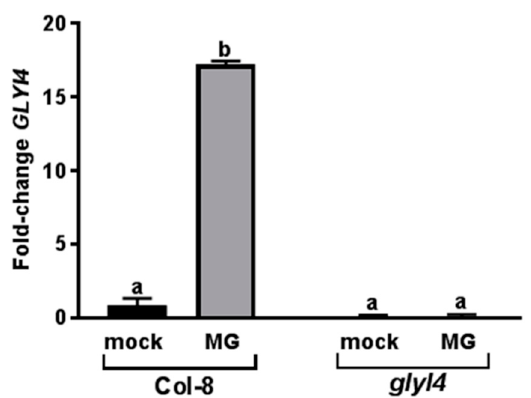
Figure 1. Glyoxalase ( GLYI4) gene expression analysis in Arabidopsis Col-8 and glyI4 mutant after methylglyoxal (MG) treatment. qRT-PCR analysis of GLYI4 in Col-8 and glyI4 leaves treated with MG and a mock solution. Fold change is relative to the expression in mock-treated plants and normalized to the reference gene PP2AA3 . GLYI4 gene expression analyses were performed 24 h after MG treatment of five-week-old plants. Shown data are means of three biological replicates. Error bars represent SEM. Di ff erent letters indicate significant statistical di ff erences (Two-ways ANOVA, Tukey’s post-hoc, p < 0.0001).